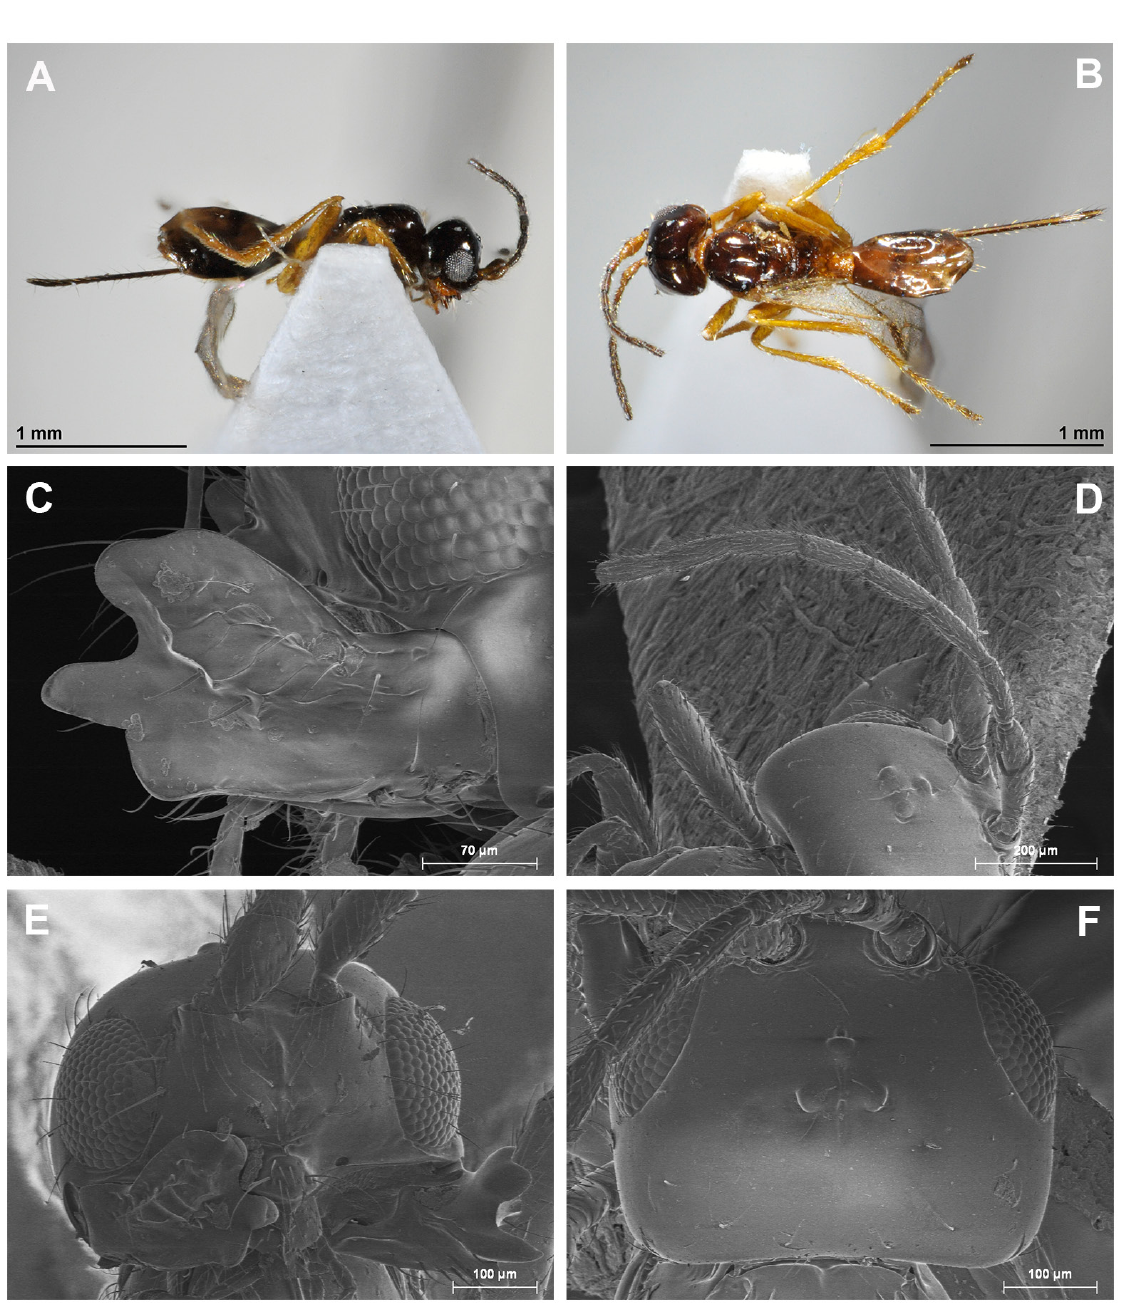
Fig. 37. Asobara malawiana Fischer, 2007, ♀, holotype (OLML). A . Habitus, lateral view. B . Habitus, dorsal view. C . Mandible. D . Antenna. E. Head, front view. F . Head, dorsal